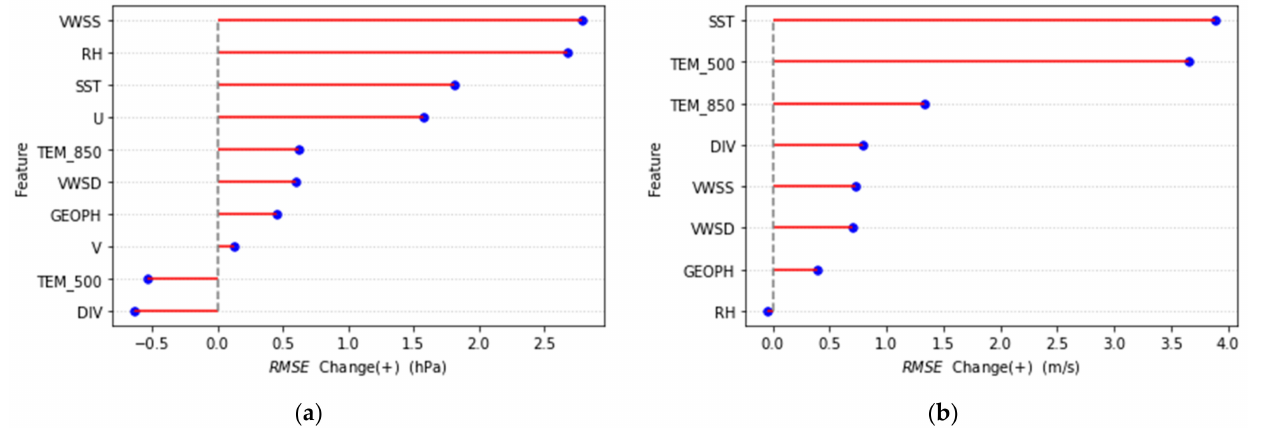
Figure 6. RMSE changes as a result of removing the corresponding predictor. ( a ) Result of MCP. ( b ) Result of MWS. Grey dashed lines: the RMSE of control model which was constructed by all